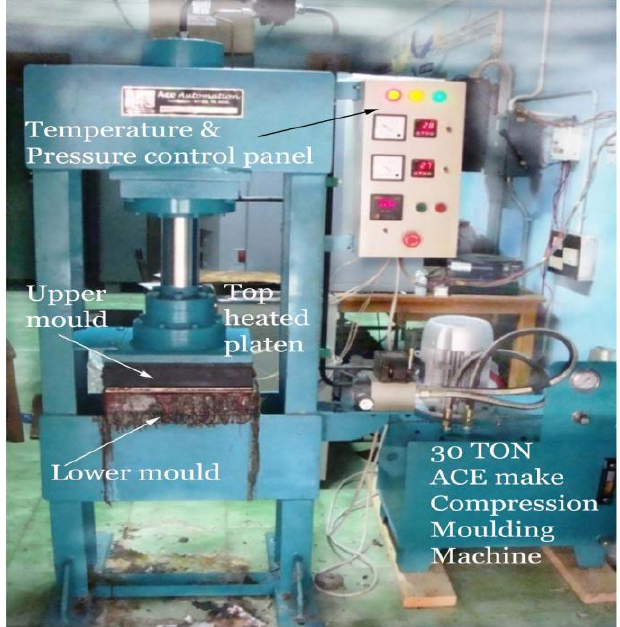
Fig. 1. Photographic image of ACE make Compression Moulding Machine